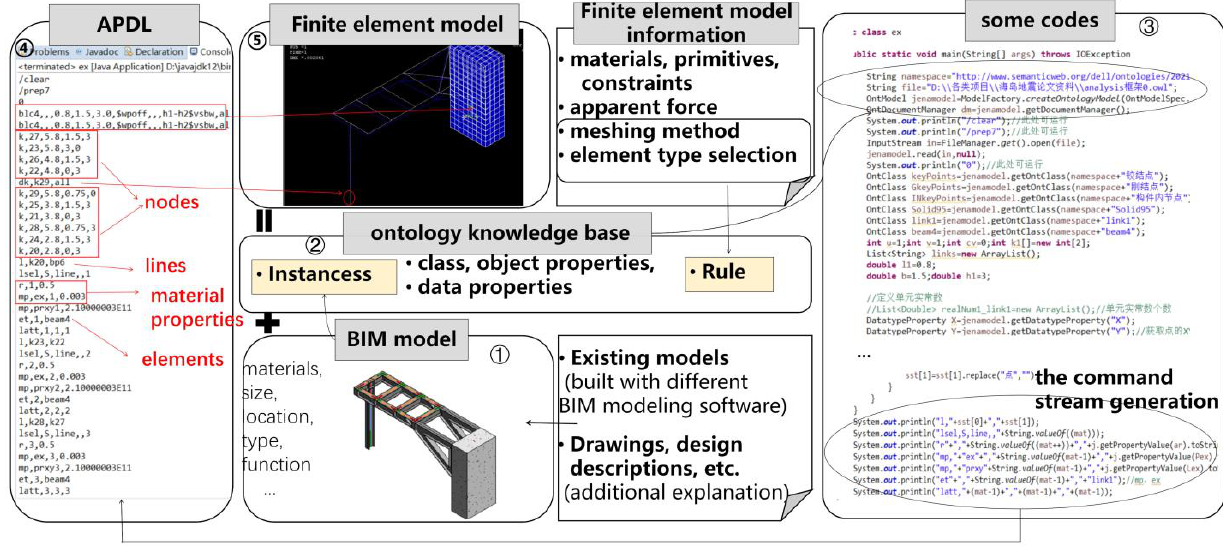
graphic element information, material information, element type, meshing